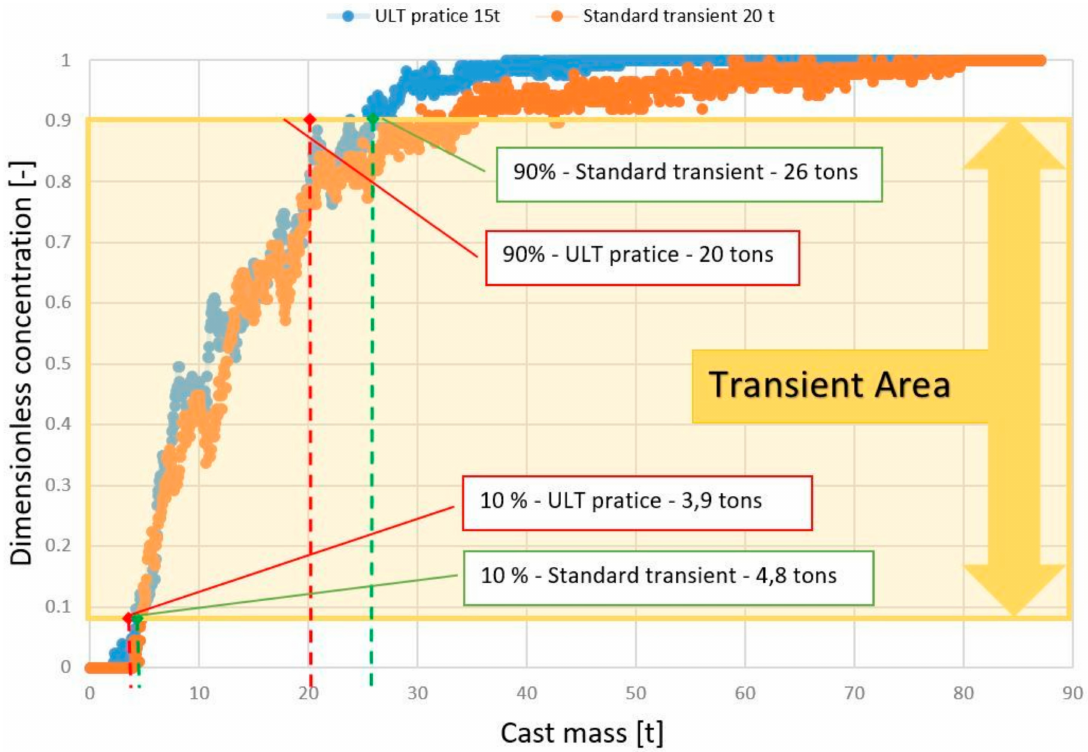
Figure 4. F-curves for standard transition and for ULT practice (physical simulation). Table 1. Parameters for the physical simulations. ULT—ultra-low